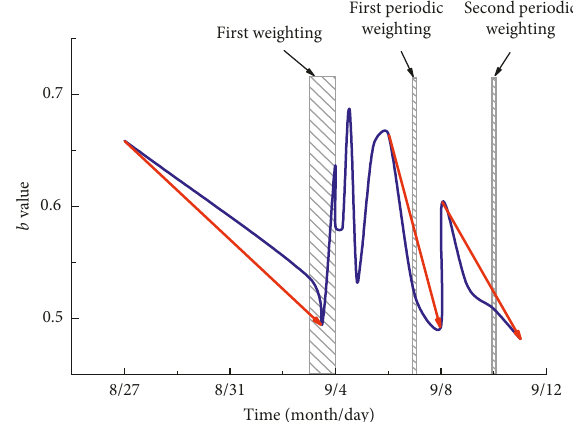
Figure 15: Changes of b value with time.